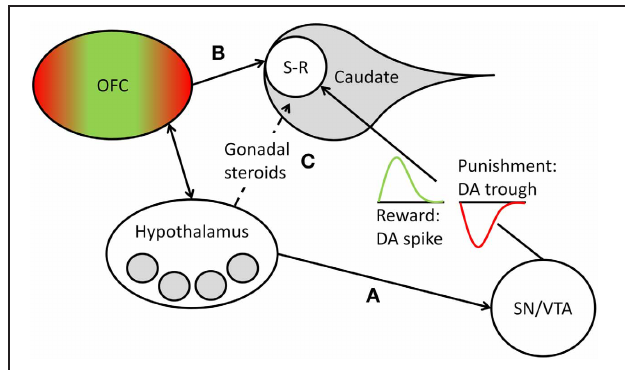
FIGURE 1 | Overview of the structures, pathways, and processes postulated to mediate nPower effects on implicit learning. Learning of new stimulus-response (S-R) sequences takes place in the head of the caudate nucleus and is reflected in the accuracy with which S-R sequences are executed (Hikosaka et al., 1999). The motivational value of the outcome of such S-R sequences is encoded by phasic DA release, with a transient spike in DA cell firing marking a reward and leading to reinforcement of the sequence and a transient trough marking a punishment and leading to a suppression of the sequence (see Bromberg-Martin et al., 2010). We propose that in dominance-related contexts, the magnitude of the phasic DA changes that drive S-R learning in the caudate depends on nPower-associated liking of power-specific rewards and disliking of power-specific punishers, with higher nPower leading to greater DA changes in response to such events. We furthermore propose that nPower-dependent scaling of (dis)liking responses to power-specific (dis)incentives takes place in need-specific areas (shaded gray circles) of the hypothalamus and in reward- and punishment-related hedonic evaluation areas of the orbitofrontal cortex (OFC; green represents the medial reward-related areas, red the lateral punishment-related areas; see Kringelbach, 2005), which closely interacts with the hypothalamus. nPower-specific incentive evaluation in these areas can influence striatal S-R learning by (A) hypothalamic modulation of DA release from the substantia nigra/ventral tegmental area (SN/VTA), (B) direct projections from the OFC to the head of the caudate, or (C) indirect modulation of striatal DA release by the influence of nPower on gonadal steroids (estradiol, testosterone), whose levels are regulated by the